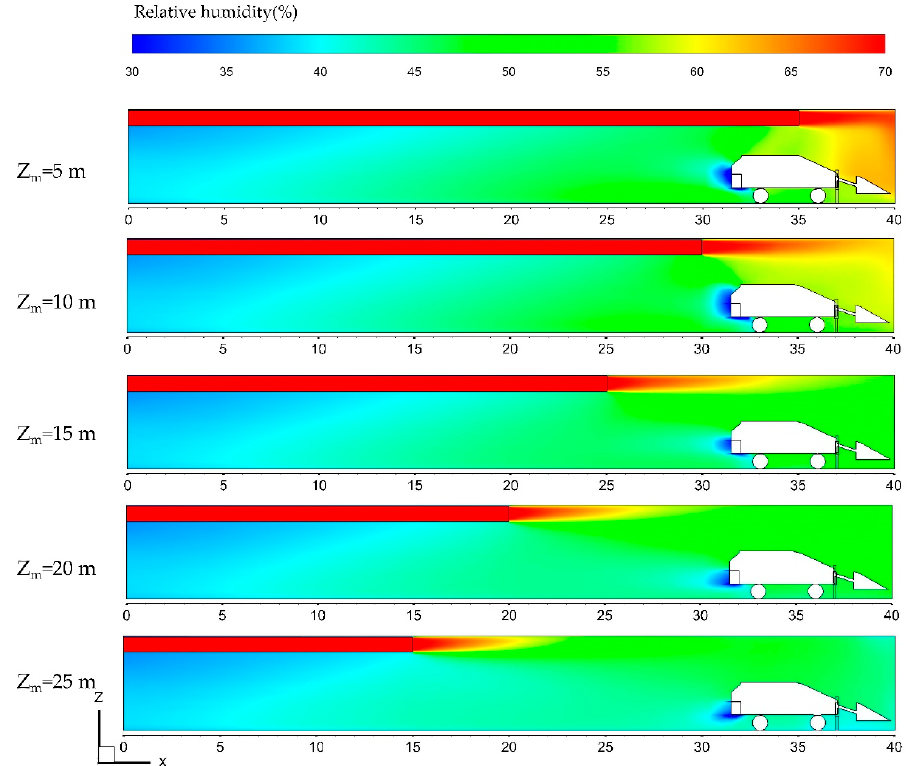
Figure 16. Airflow temperature distributions of different Z m along the airway.